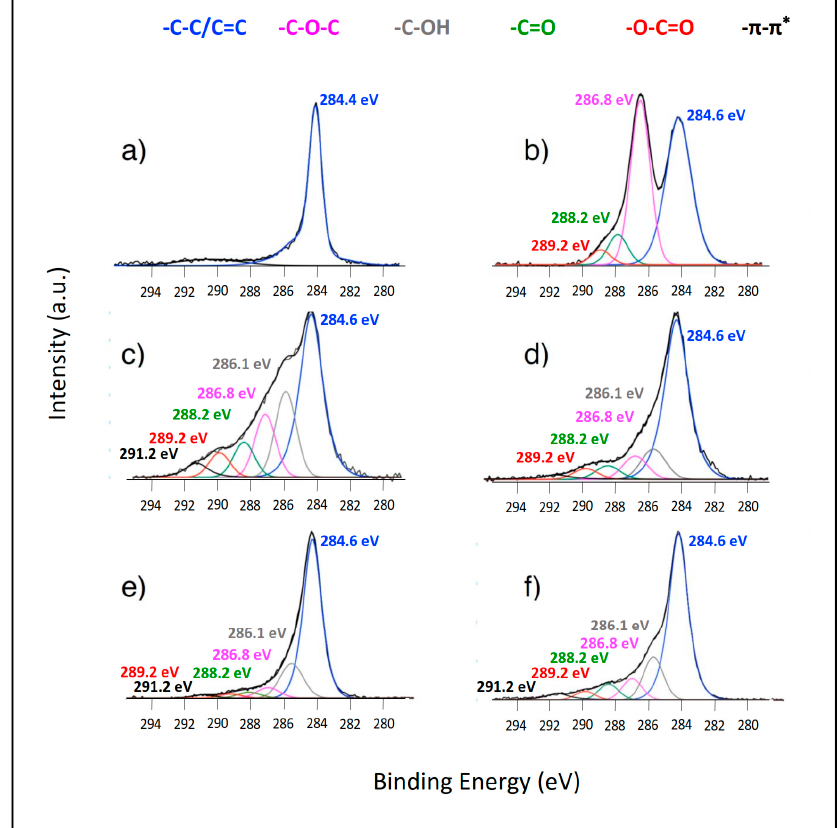
Figure 1. X-ray photoelectron spectroscopy (XPS), C 1s spectra of ( a ) graphite, ( b ) GO; ( c ) CRGO; ( d ) hTRGO; ( e ) ERGO and ( f ) TRGO.